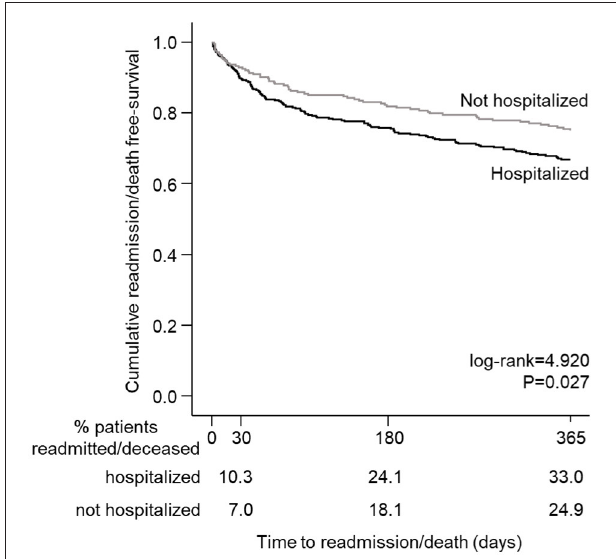
FIGURE 2 | Kaplan–Meier survival curve showing a stroke patient’s probability of remaining free of readmission/death after